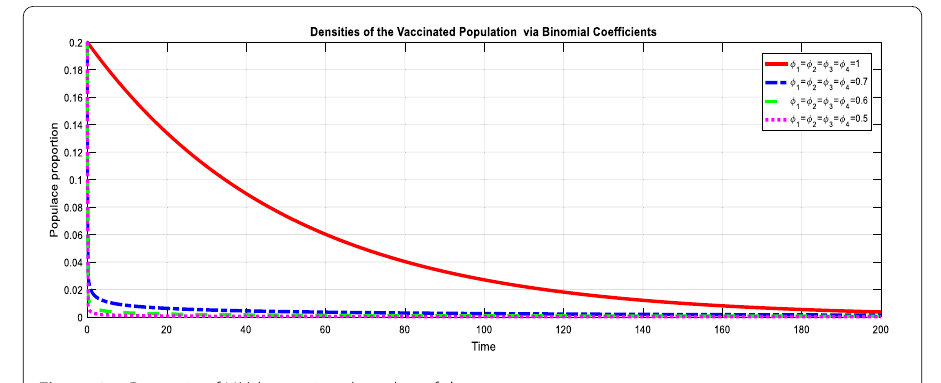
Figure 24 Dynamic of V ( t ) by varying the value of φ